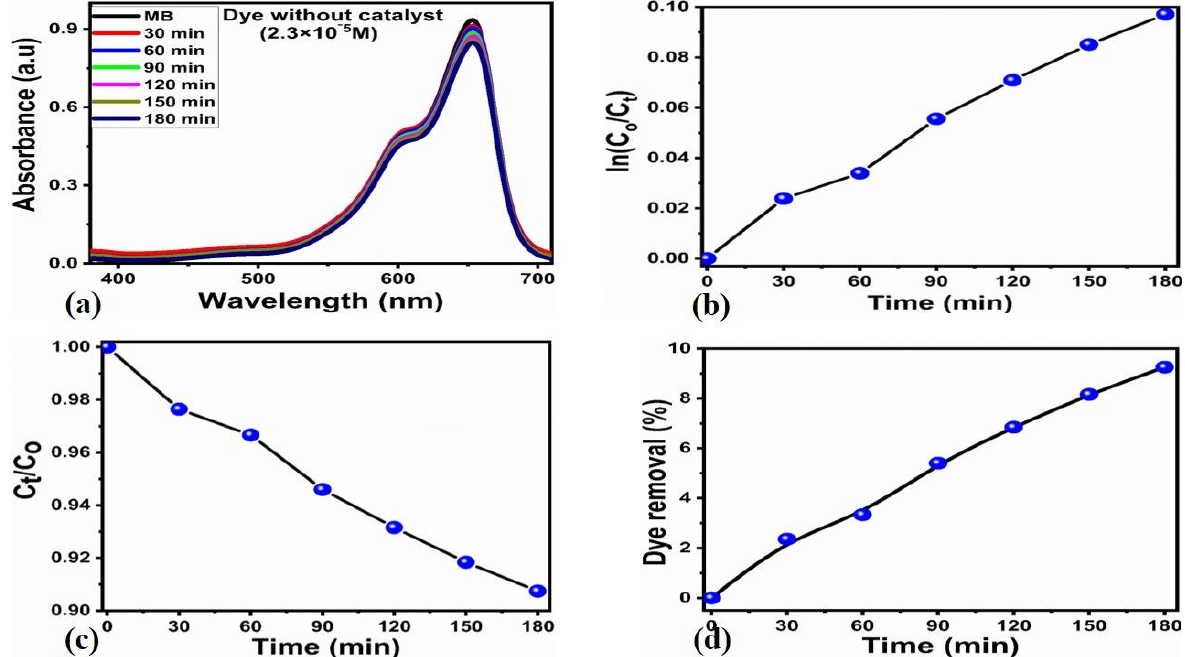
Figure 3. ( a ) UV-visible absorbance spectra measured in 2.3 × 10 −5 M MB solution in the absence